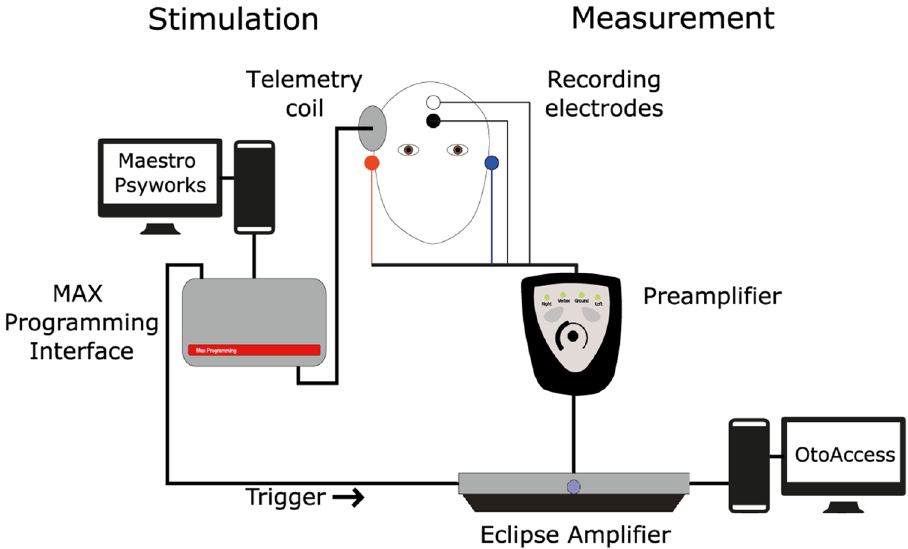
Figure 1. Setup for the EEG recording and